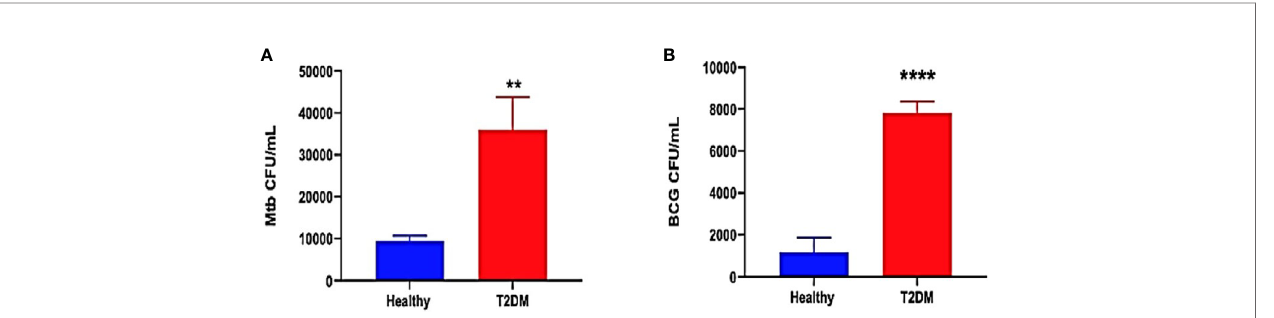
FIGURE 2 | Preclinical Findings. Survival of M. tb (A) and BCG (B) in untreated in vitro granulomas generated from PBMCs isolated from healthy subjects and individuals with type 2 diabetes. PBMCs isolated from healthy subjects and individuals with type 2 diabetes were infected with Erdman strain of M . tb Granulomas were terminated at 8-days post-infection. Cell-free supernatants were collected and stored. Granulomas were lysed with ice-cold PBS. Supernatants and granuloma lysates were plated on 7H11 agar plates containing ADC to determine the survival of M. tb and BCG. (**) indicates a p <.005, (****) indicates p